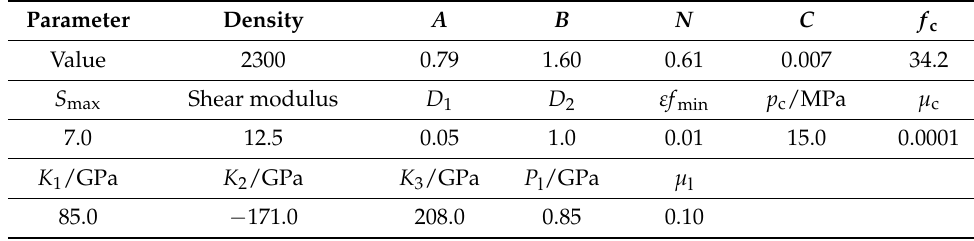
Table 5. Parameters used to model